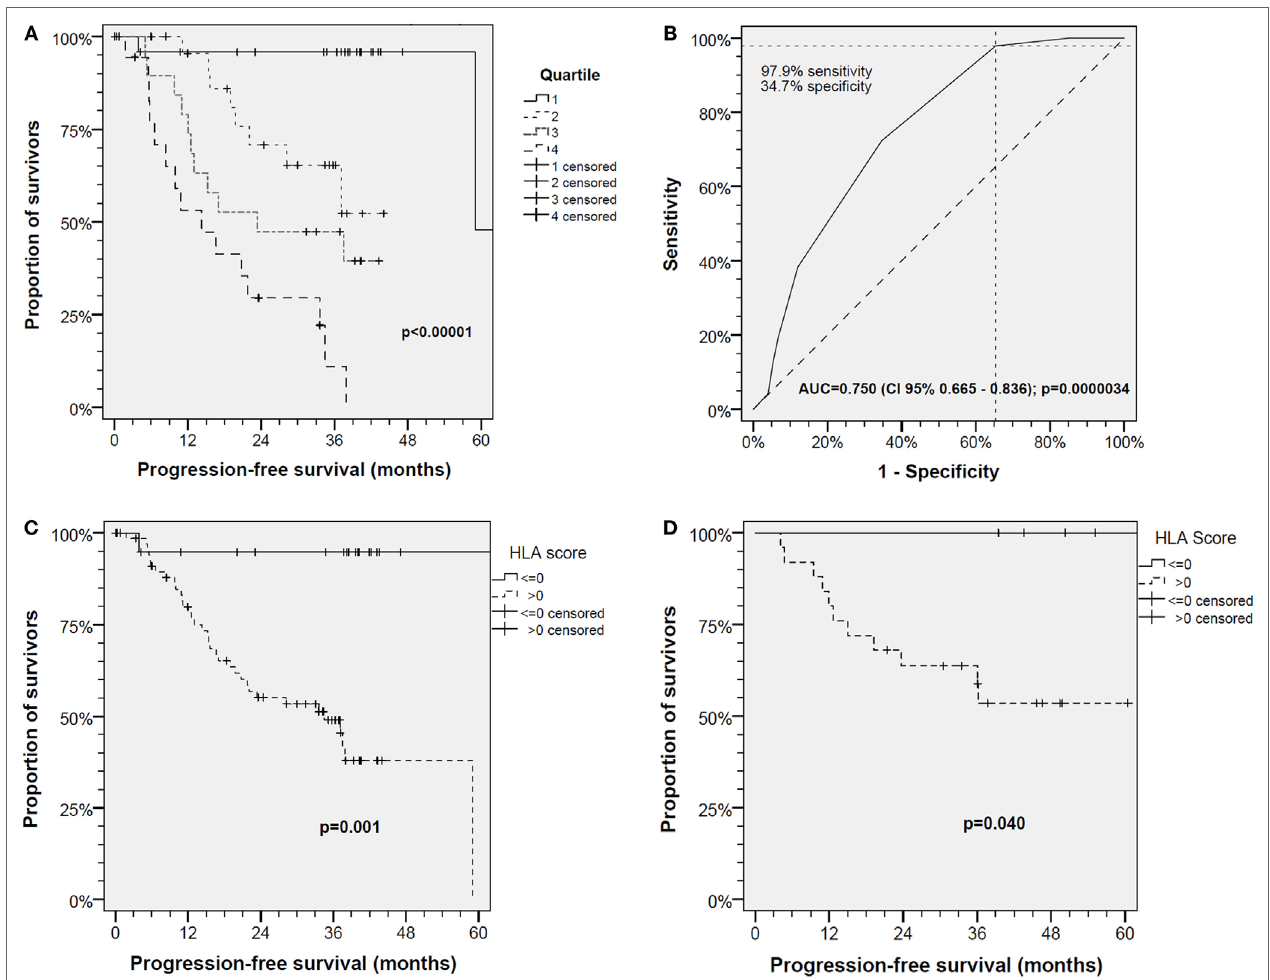
FigUre 1 | The human leukocyte antigen (HLA)-score is an independent predictor of progression-free survival (PFS) in head and neck squamous cell carcinoma (HNSCC) patients. (a) PFS in the N = 90 HNSCC patients of the test cohort (TC) respective to HLA-score quartiles; (B) receiver operating characteristics for PFS event versus HLA-score demonstrate high significance and optimum classification with 97.9% sensitivity and 34.7% specificity at a cutoff of 0.5 in the TC; (c) PFS in the TC of N = 90 HNSCC patients classified according to cutoff 0.5; (D) PFS in the N = 32 patients of the independent validation cohort classified according to cutoff 0.5 confirms the findings in the